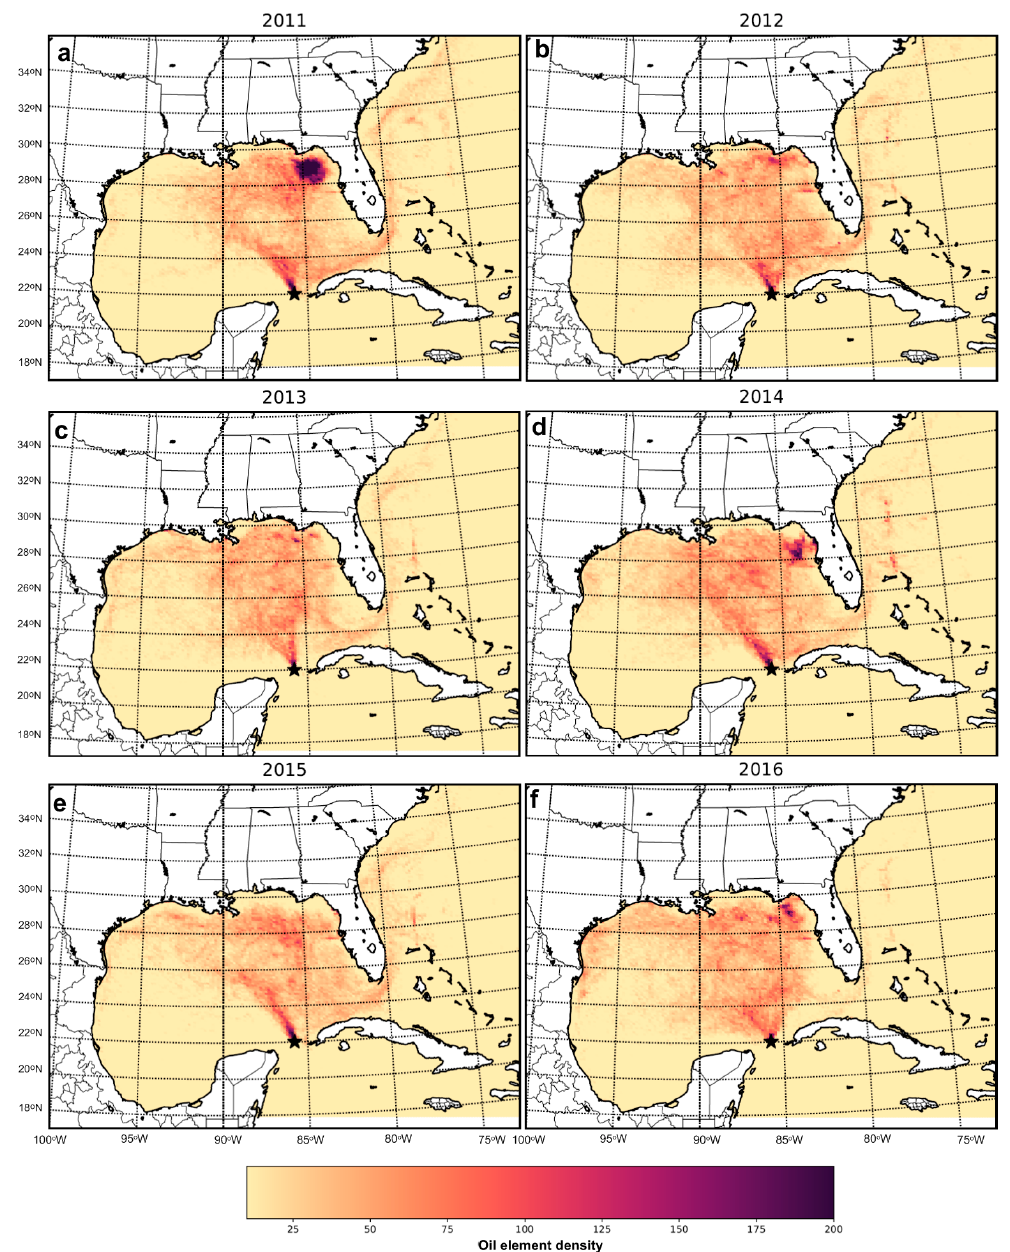
Figure 5. Annual maps of the density of oil elements from the simulations where 100 oil elements were released daily at Point 1 (black star) for ( a ) 2011, ( b ) 2012, ( c ) 2013, ( d ) 2014, ( e ) 2015, and ( f ) 2016. Each grid cell in the plot is ~36 km 2 . All element positions are shown. If each Lagrangian element initially represents 1 ton of oil, 200 elements per grid cell will correspond to a ~2.5 mm oil layer assuming 50% oil mass loss (Figure 2). The values represent the sum of oil elements that crossed over each model cell during each year.